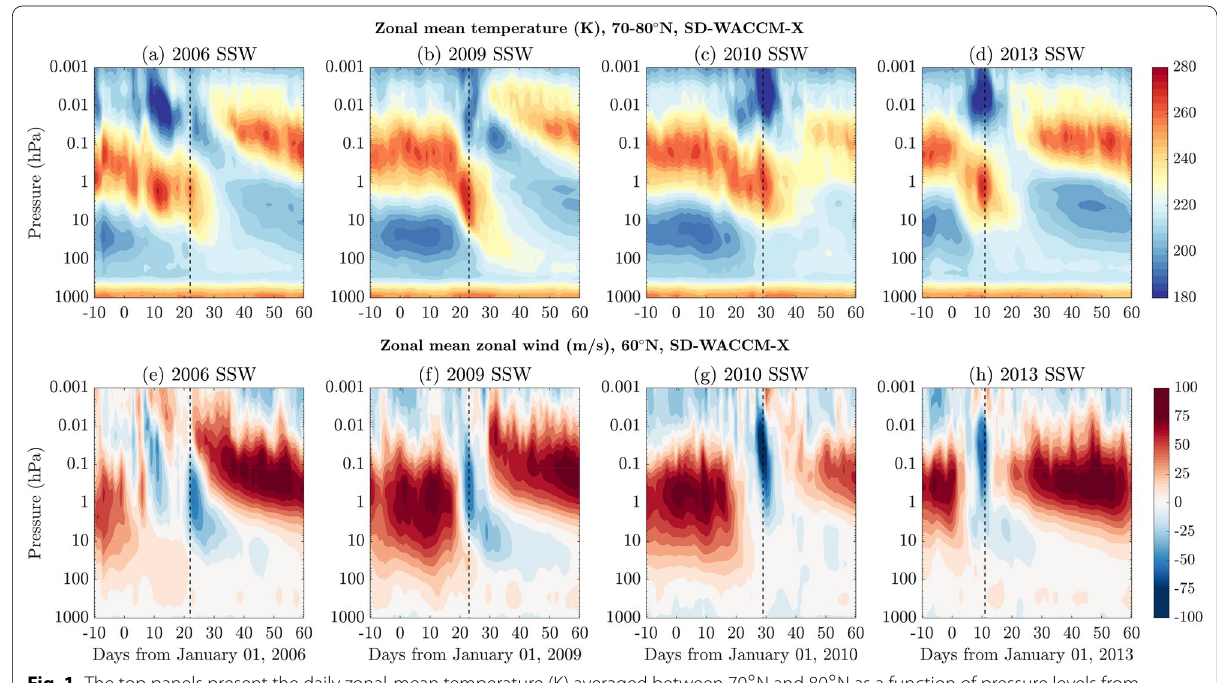
Fig. 1 The top panels present the daily zonal-mean temperature (K) averaged between 70 ◦ N and 80 ◦ N as a function of pressure levels from SD-WACCM-X simulations for (a) 2006, (b) 2009, (c) 2010 and (d) 2013 NH SSWs. The bottom panels present the SD-WACCM-X simulated daily zonal-mean zonal winds (m/s) at 60 ◦ N as a function of pressure levels for the above-mentioned SSWs in e – h . The black dashed lines mark the day of polar vortex weakening (PVW) for the corresponding